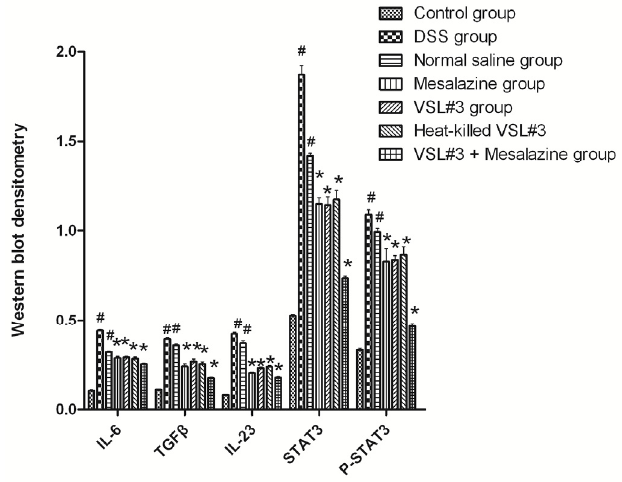
Figure 6. Western blot densitometry of the proteins IL-6 , IL-23 , TGF- β , STAT3 , and P-STAT3 in colon tissue samples from groups of rats ( # p < 0.05 versus control group; * p < 0.05 versus DSS